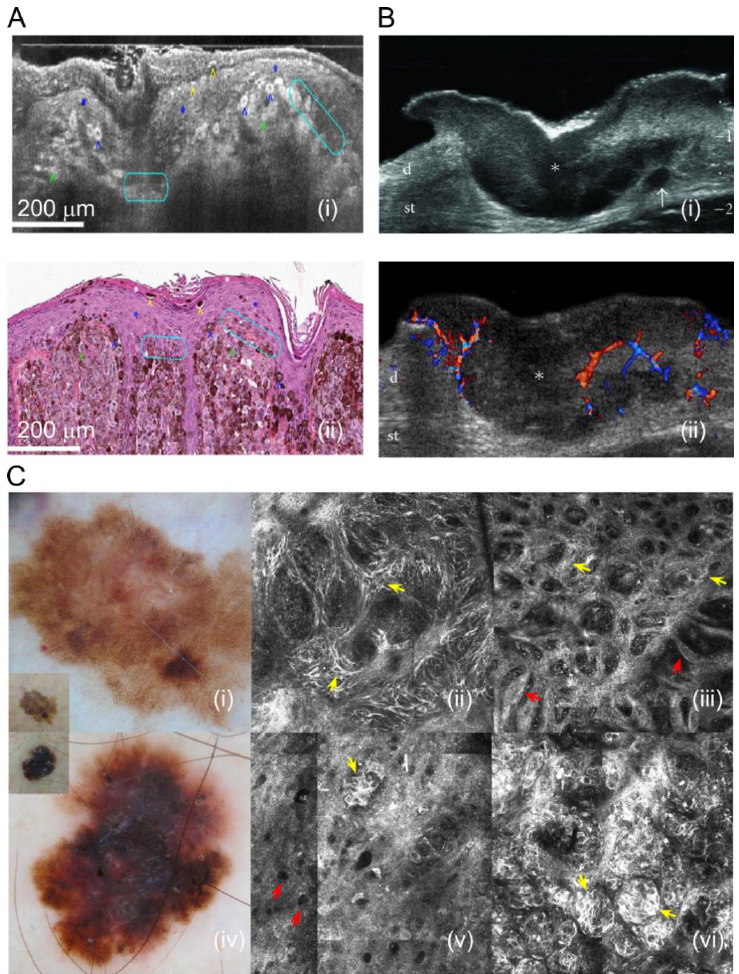
Figure 9. Morphological melanoma features ( A ) (Reproduced from “Line field confocal optical Figure9. Morphologicalmelanomafeatures( A )(Reproducedfrom“Linefieldconfocalopticalcoherence coherence tomography for high-resolution noninvasive imaging of skin tumors”, tomography for high-resolution noninvasive imaging of skin tumors”, doi:10.1117 / 1.Jbo.23.10.106007 by Dubois et al., published by SPIE, reproduced under Creative Commons Attribution 3.0 Unported License from [91], © The Authors). LC-OCT (Line field-optical coherence tomography) image of cutaneous melanoma ( i ) and a histopathology slide of the corresponding lesion ( ii ). Blue star: epidermis; white star: stratum corneum; blue arrowhead: pagetoid spread of tumor epithelial cells; yellow arrowhead: tumor cells being eliminated; green arrowhead: clumps of melanocytic tumor cells in the dermis; turquoise circles: partial DEJ (dermal–epidermal junction disruption) [91]. ( B ) (Reproduced from “Sonography of the primary cutaneous melanoma: a review” by Wortsman under the Creative Commons Attribution License [92]) Transverse ultrasound image ( i ) of melanoma on the abdominal wall demonstrating fusiform hypoechoic lesion (*) that is invading the dermis and subcutaneous tissue. The arrow is pointing to a satellite metastasis. Doppler ultrasound ( ii ) shows increased vasculature and blood flow. Abbreviations: d: dermis; st: subcutaneous tissue [92]. ( C ) (Reproduced from “Reflectance